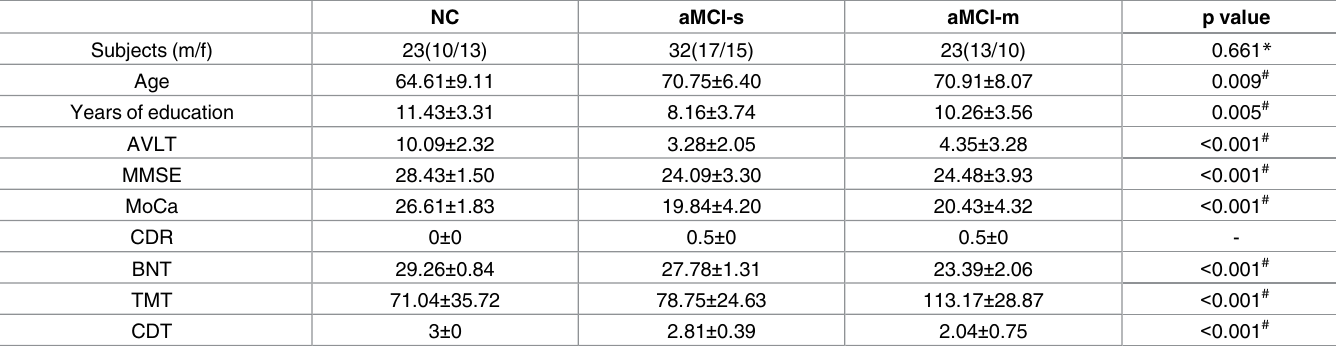
Table 1. Demographic characteristics of the three groups of participants including NC, aMCI-s and